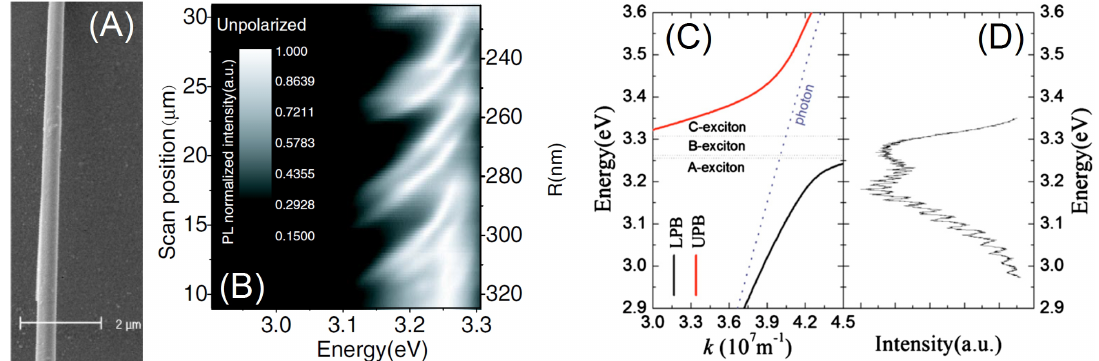
Figure 9: (A) Magnified SEM image of a ZnO tetrapod. (B) Spatially resolved PL mapping along the tapered arm with the excitation laser polarization E || c -axis and detection unpolarized. (C) Exciton-polaritons dispersion curve from a ZnO microrod. The blue dashed line is for the pure cavity mode dispersion. The horizontal dashed lines denote the exciton A, B, and C. (D) The TE-polarized µ -PL spectrum from the microrod. Reproduced with permission from Ref. [108] (A, B) and [110] (C, D). SEM: secondary electron microscope; PL: photoluminescence; TE: transverse electric.